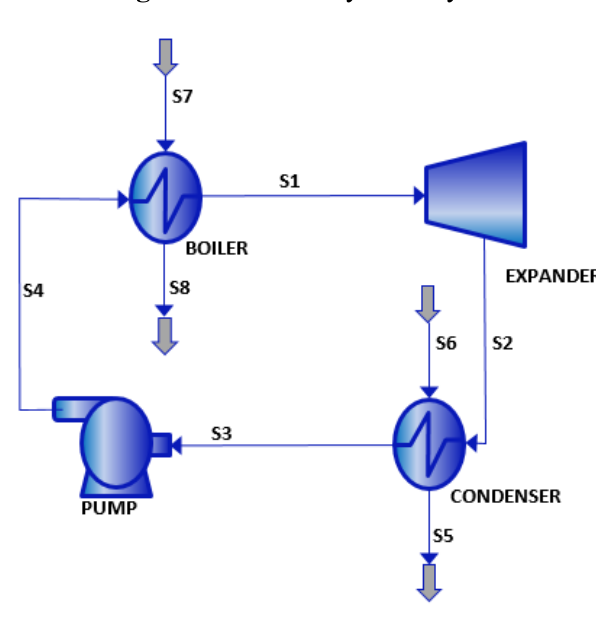
Figure 1. General system